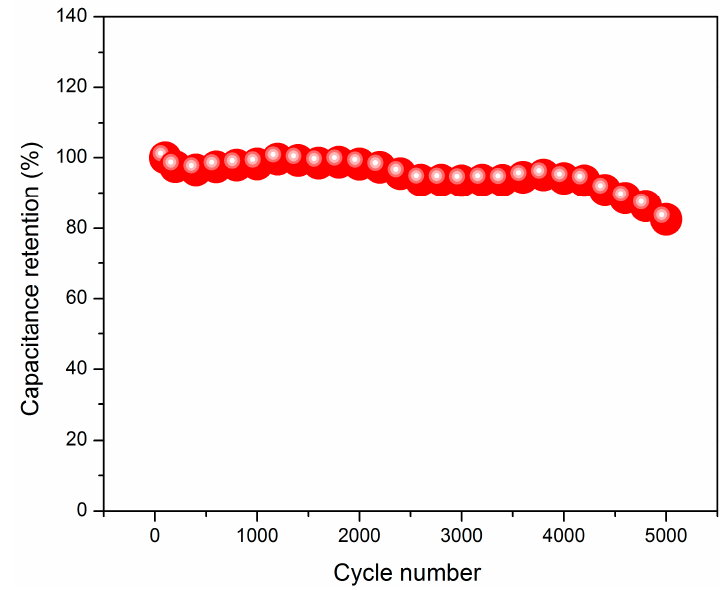
Figure 8. Cycling stability of PVA/PEDOT nanofibers//rGO asymmetric supercapacitor.